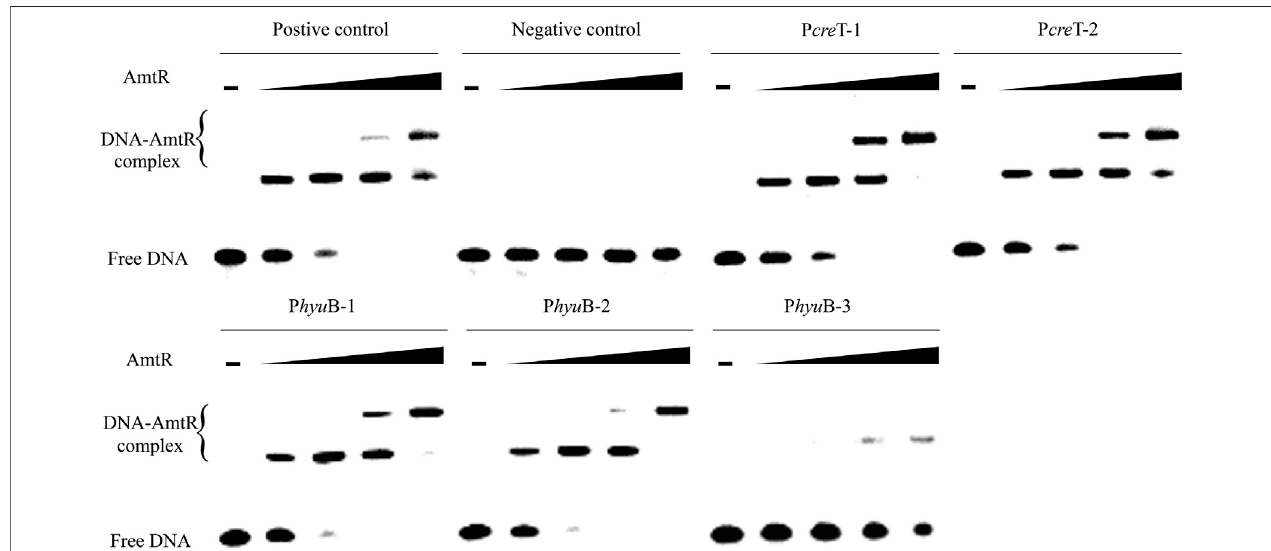
FIGURE 3 | AmtR interacts in vitro with different DNA fragments. Minus represents that AmtR was not added, the lower band is the free DNA that is unbound with AmtR. Black triangle represents that AmtR was gradually increasing. The DNA fragments were annealed using two complementary single-stranded oligonucleotides. The positive control is the protomer region of amt A reported, and the negative control is the protomer region of hyu B that does not contain the AmtR binding sequence. Increasing amounts of AmtR (0, 0.1, 0.2, 0.4, and 0.8 μ g) and 100 ng DNA fragments were used.